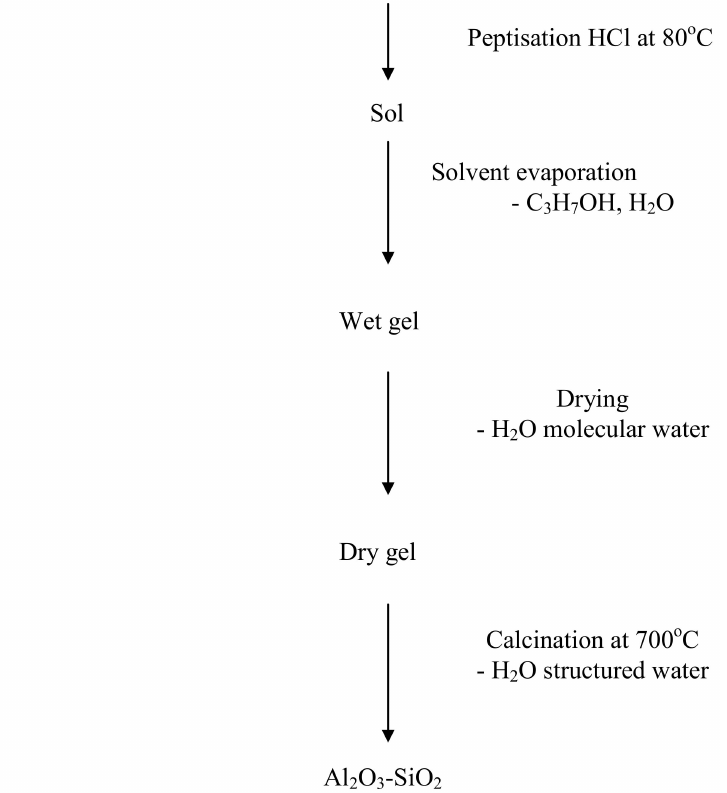
Figure 1. Schemes of the sol-gel method used in order to produce aluminium oxide with an admixture of silicon